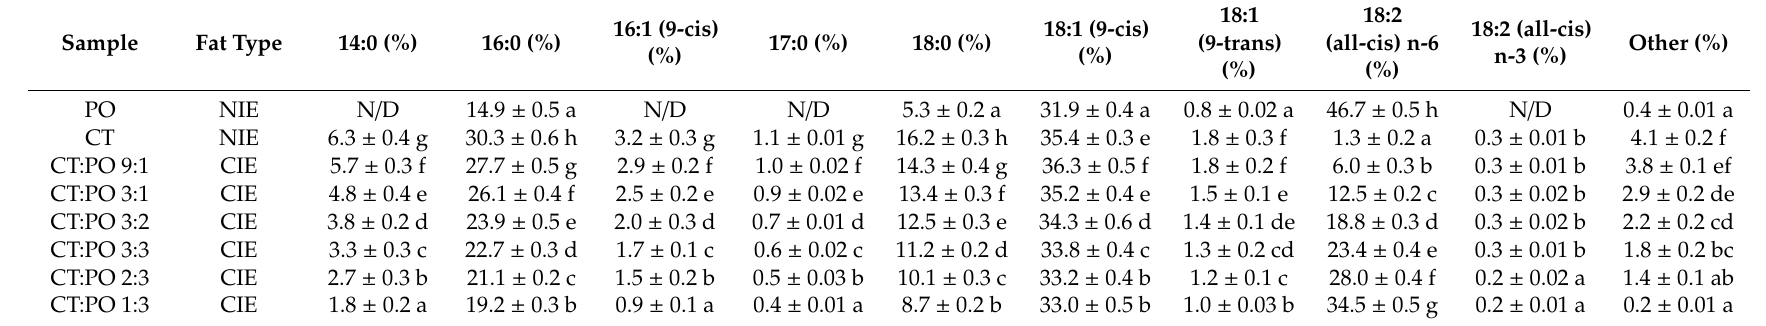
Table 2. Fatty acids profile of the raw fats and interesterified fat